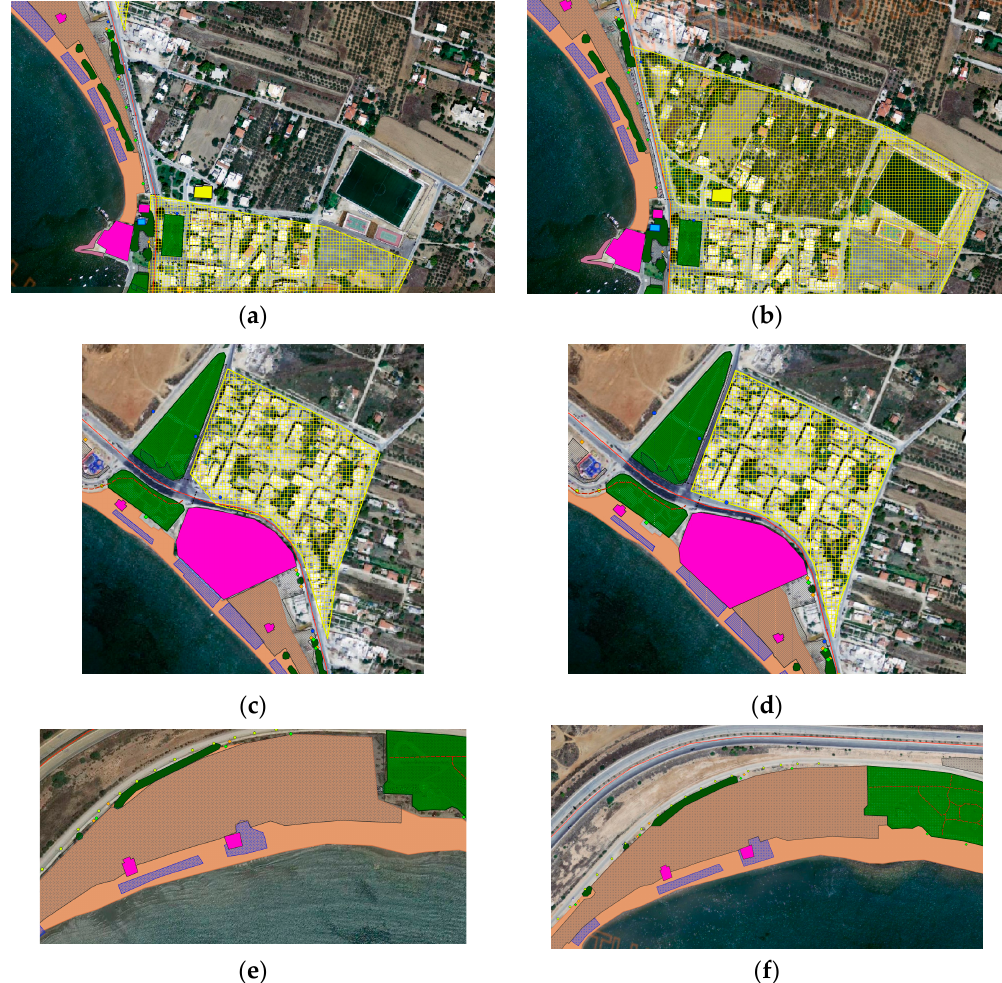
Figure 4. Differences between the initial crowdsourced map ( a,c,e ) and the final edited map by the professional ( b,d,f ). Source: own elaboration.